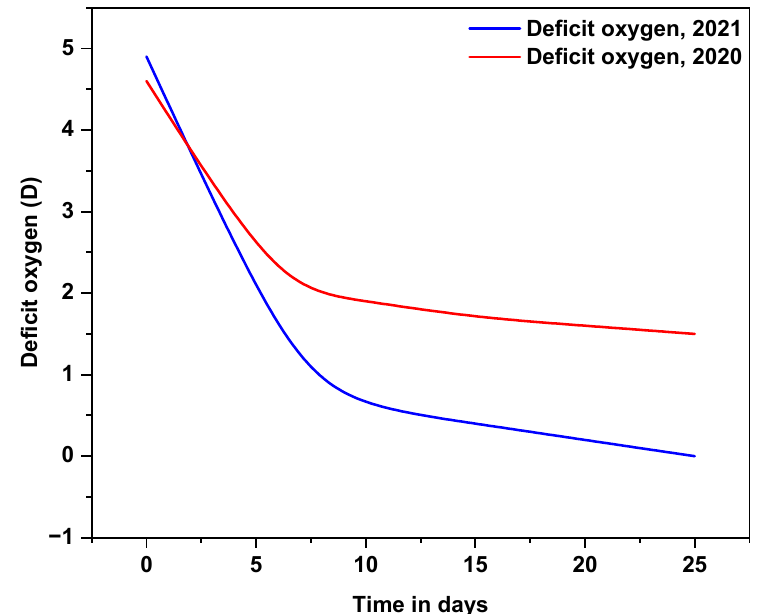
Figure 7. Comparison of simulation results for 2020 and 2021 showing the validity of modeling and simulation of the Chambal River water quality.